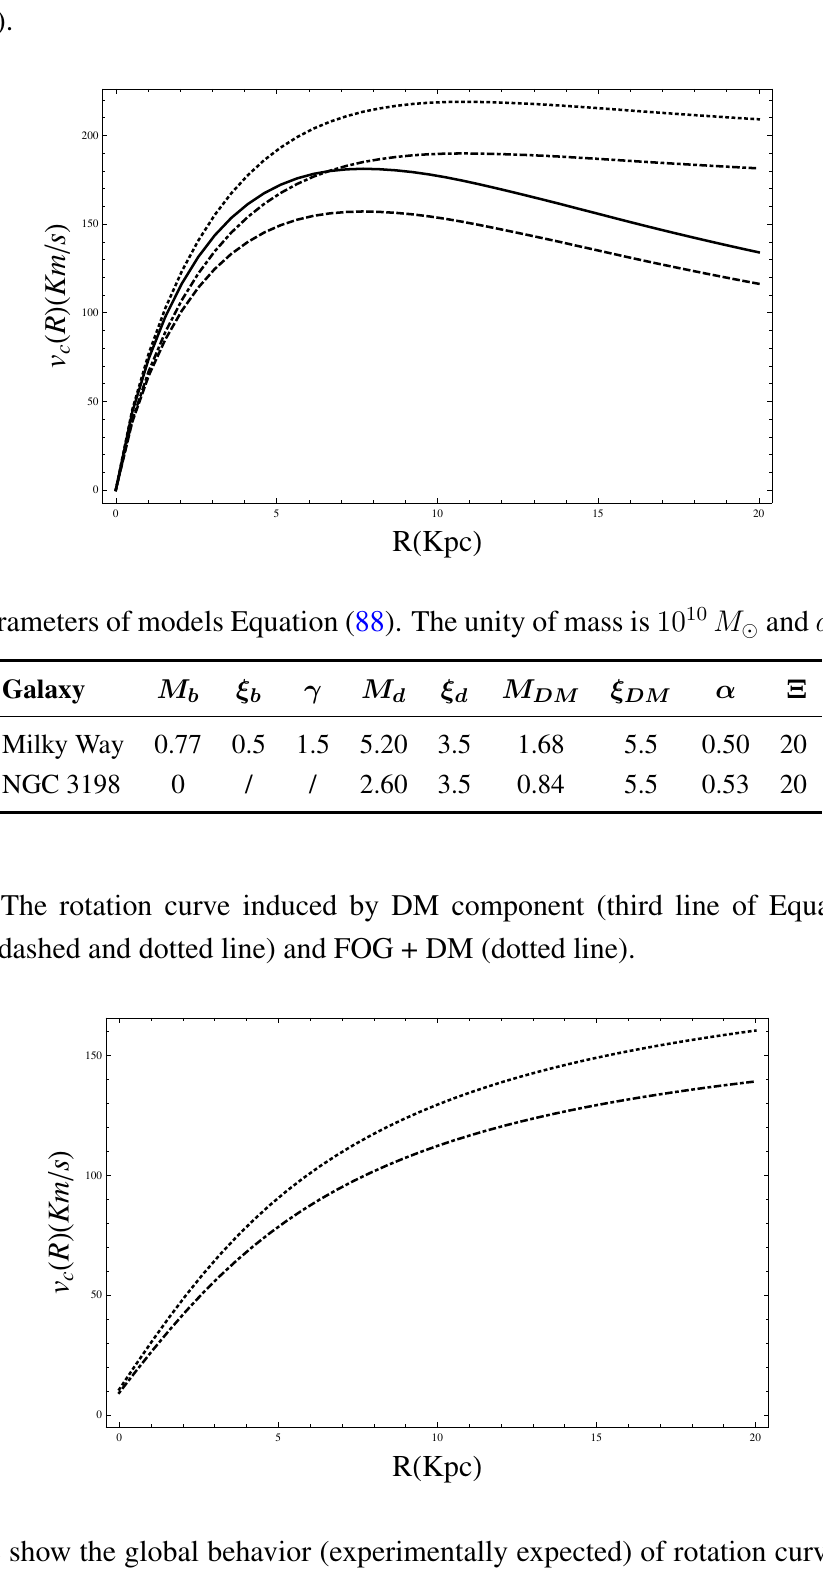
Figure 3. The rotation curve induced by disk component (second line of Equation (88)): GR (dashed line), GR + DM (dashed and dotted line), FOG (solid line) and FOG + DM (dotted line).